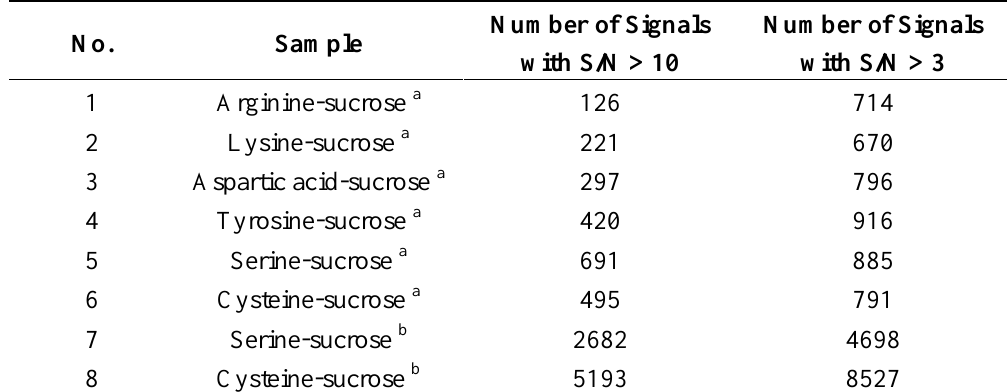
Table 1. The number of peaks observed for samples in ESI-TOF-MS and FT ICR-MS in negative ion